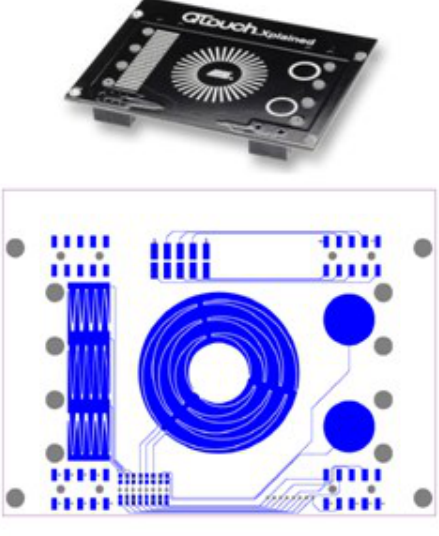
Fig. 4. Tactile capacity sensor card Qtouch Xplained